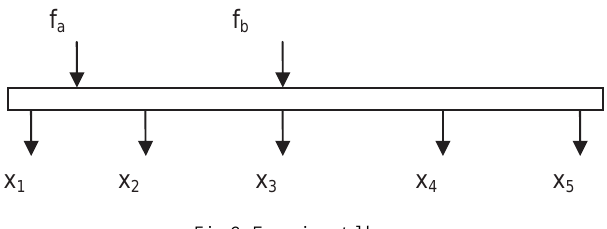
Fig. 2. Experimental